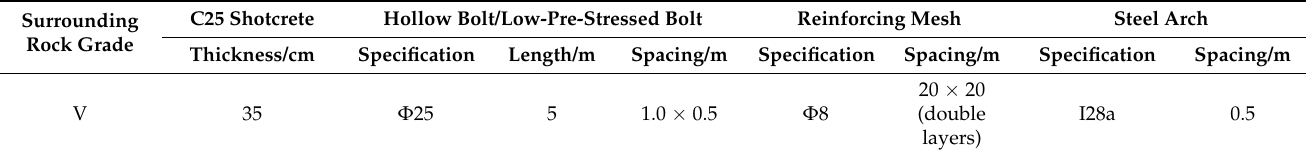
Table 3. Optimization scheme for the initial support parameters of tunnel